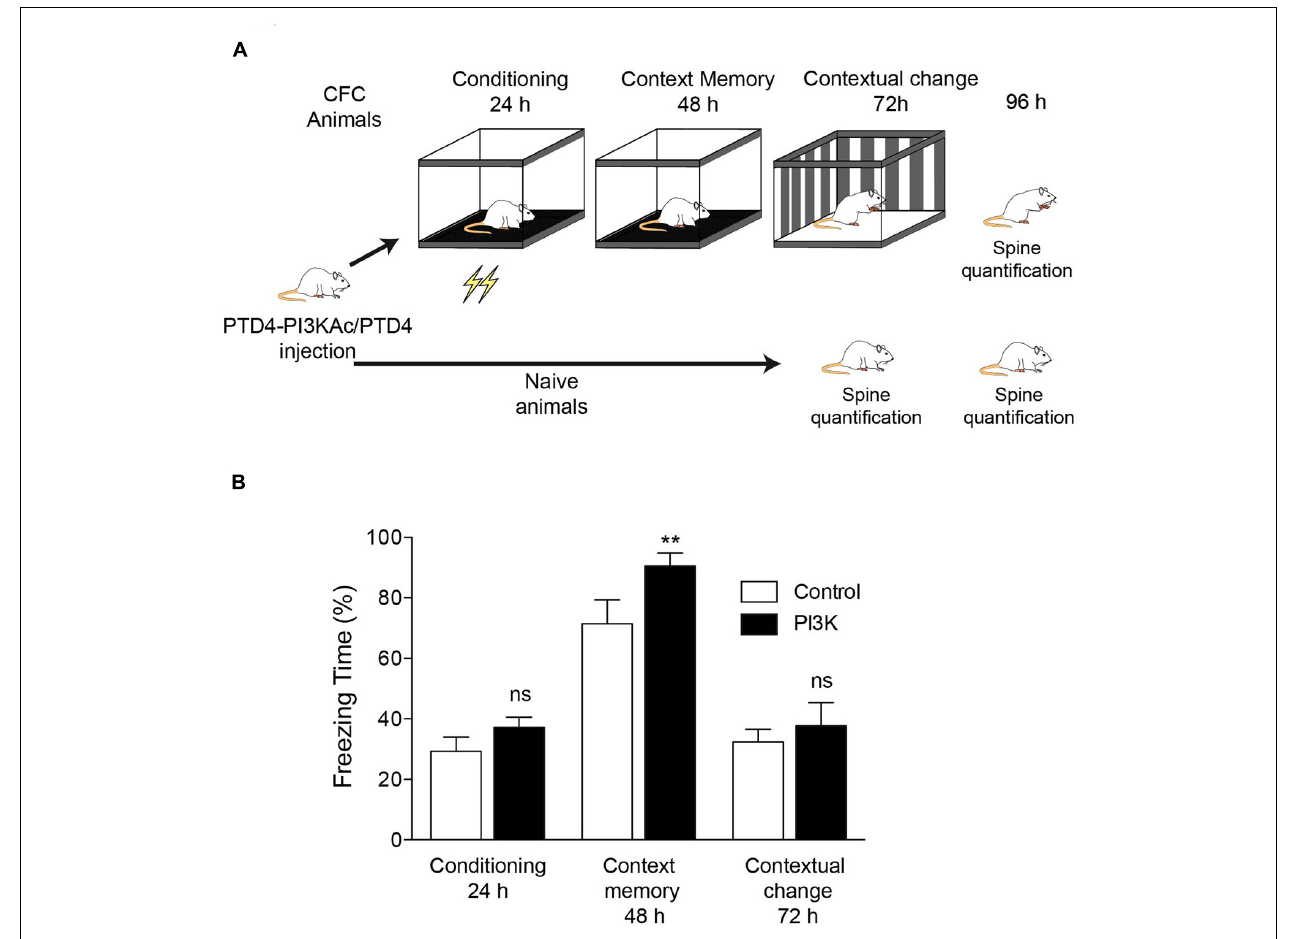
FIGURE 1 | PI3K activation improves a hippocampal-dependent learning behavior. (A) Illustration depicting the experimental design. All animals were subjected to the same handling treatment before the experiments. At time 0, they were injected either PTD4-PI3KAc or PTD4 as control.The experimental group was subjected to the CFC test (CFC animals), whereas the control group (naive animals) remained in their cages throughout the entire experiment. (B) CFC test results for animals injected with either PTD4-PI3KAc (black bars, n = 10) or the PTD4 control transduction domain